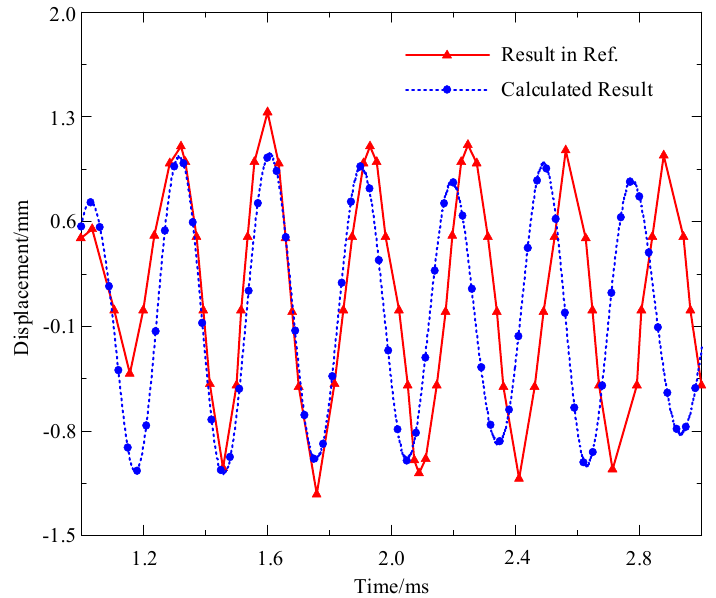
Figure 6. Comparison of calculated vibration feature of plate with result in Ref. [23].